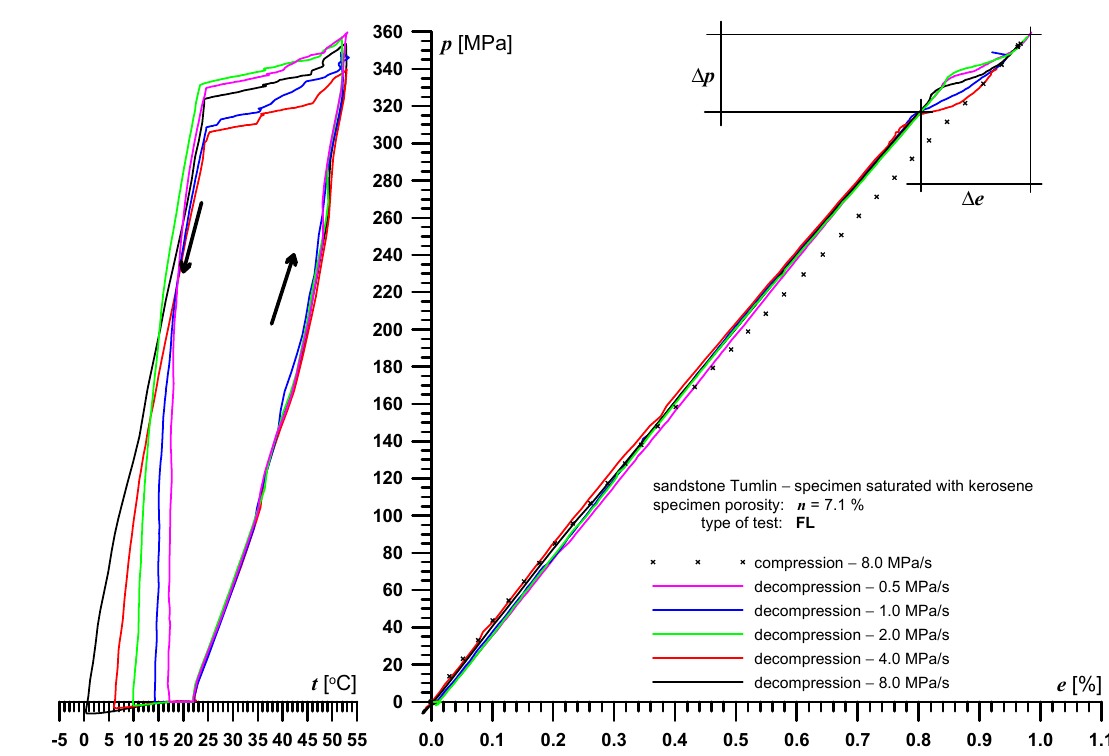
Figure 7. FL test result for Tumlin sandstone. Left : relationship between hydrostatic pressure and temperature (the arrows indicate the direction of change of hydrostatic pressure), right : relationship between hydrostatic pressure and volume change.